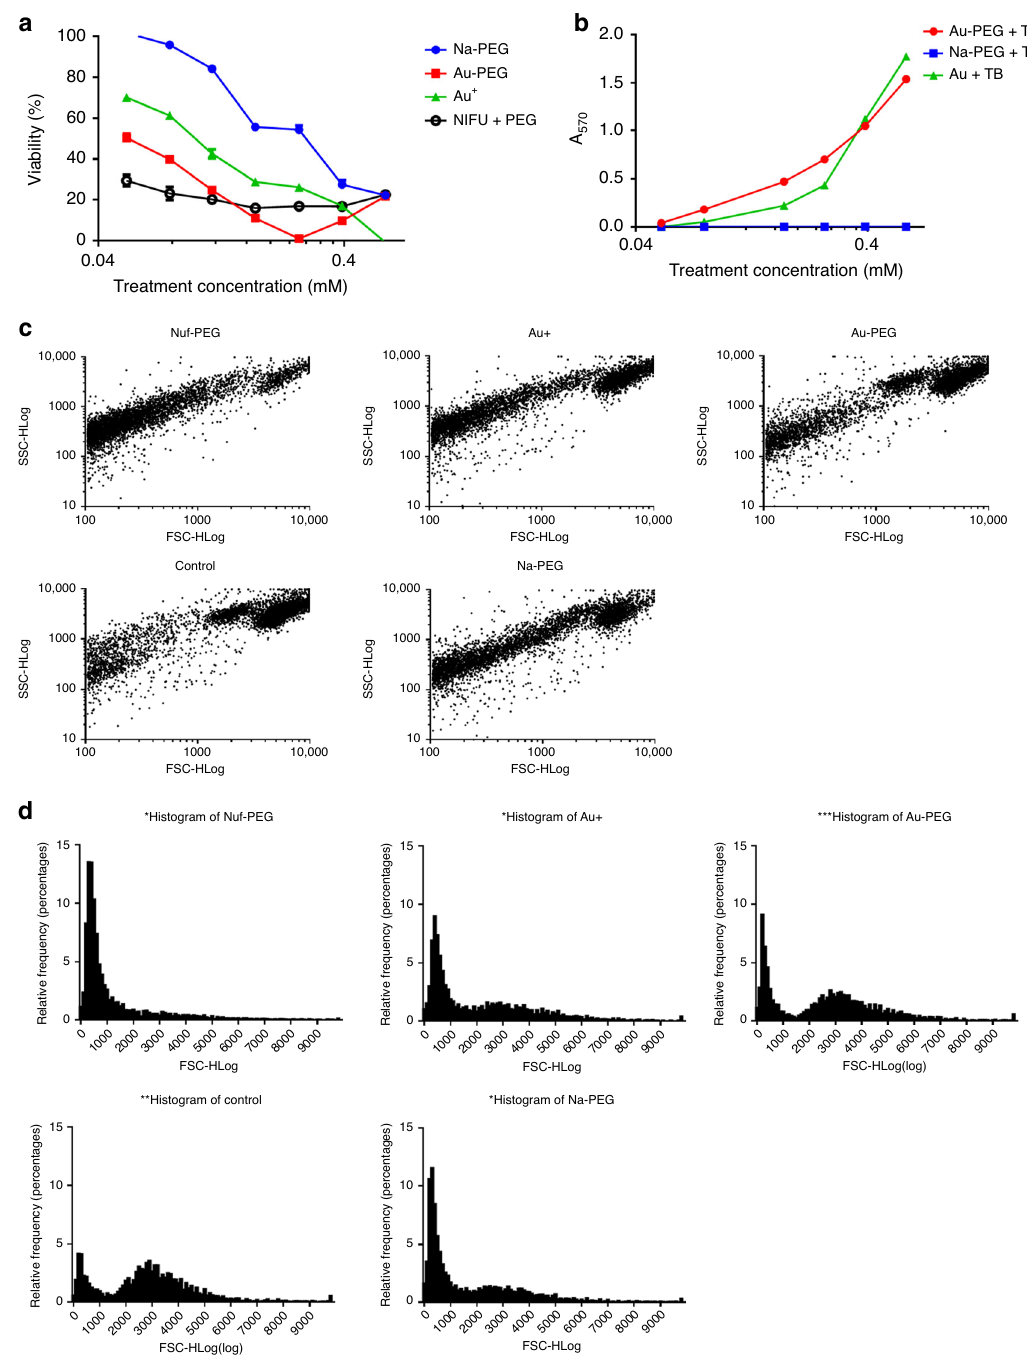
Fig. 6 Cell viability of MCF-7 when treated with ionic gold. a Cells as assessed via thiazolium blue (MTT) metabolic assay for cells treated with Na – PEG (blue), Au 3 + (green), Au – PEG (red) and nifuroxazide mixed with PEG (black). For ( a ) and ( b ), error bars are standard deviation of the mean ( n = 3 biologically independent samples). Titrated light interactions between ionic-PEG mixtures (same color scheme) as admixed with thiazolium blue at concentrations used for MTT assay. Comparison of forward scatter vs side scatter plot for different samples at 0.24 mM treatments ( c ). Representative histogram analysis of different samples ( d ) showing two populations, one corresponding to dead cells at low FSC, whereas the second at higher FSC corresponding to healthy cells. Error bars in ( a ) and ( b ) are standard deviations of the